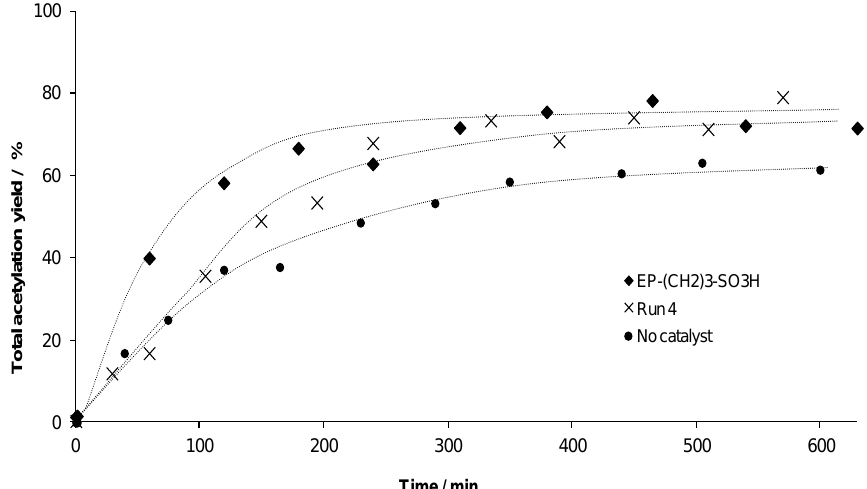
Figure 7. Recyclability experiment for EP–(CH catalytic activity of the pristine material and the third catalytic run. The blank reaction is presented for clarity. The lines are intended as visual aids